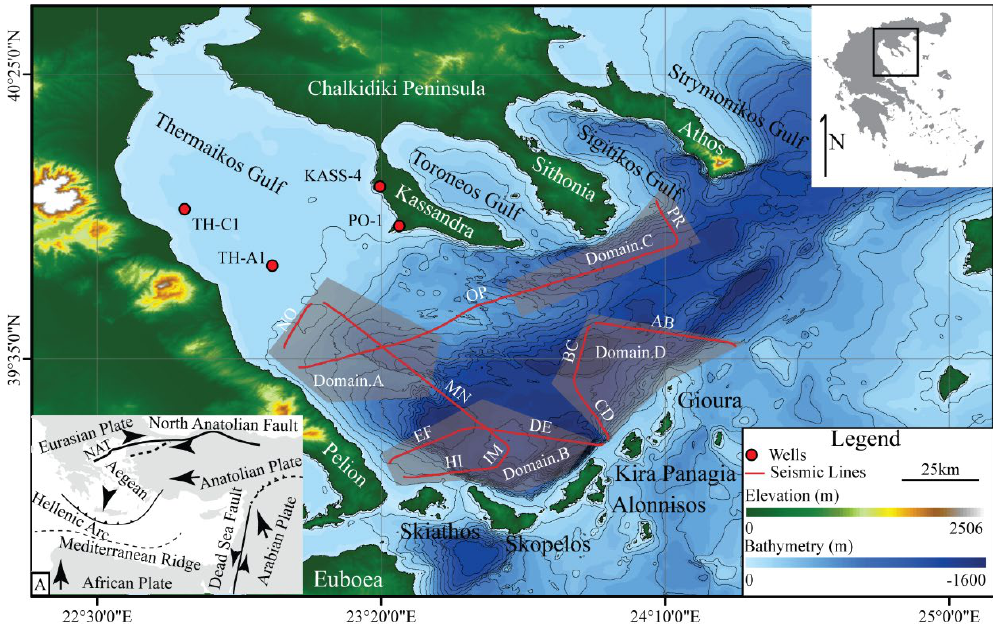
Figure 1. Bathymetry of the area around the western half of North Aegean Trough. The seismic lines acquired during SeisGreece mission analyzed in this study are shown. The shaded areas correspond and constrain the domain distinguished. ( A ) Schematic illustration of the major geodynamic interactions of the tectonic plates in the area of Eastern Mediterranean (modified after Taymaz et al. [12]). The wells in the outer Thermaikos shelf and Kassandra Peninsula are indicated. Well names: Thermaikos-C1 (TH-C1), Thermaikos-A1 (TH-A1), Posidi-1 (PO-1), and Kassandra-4 (KASS-4).